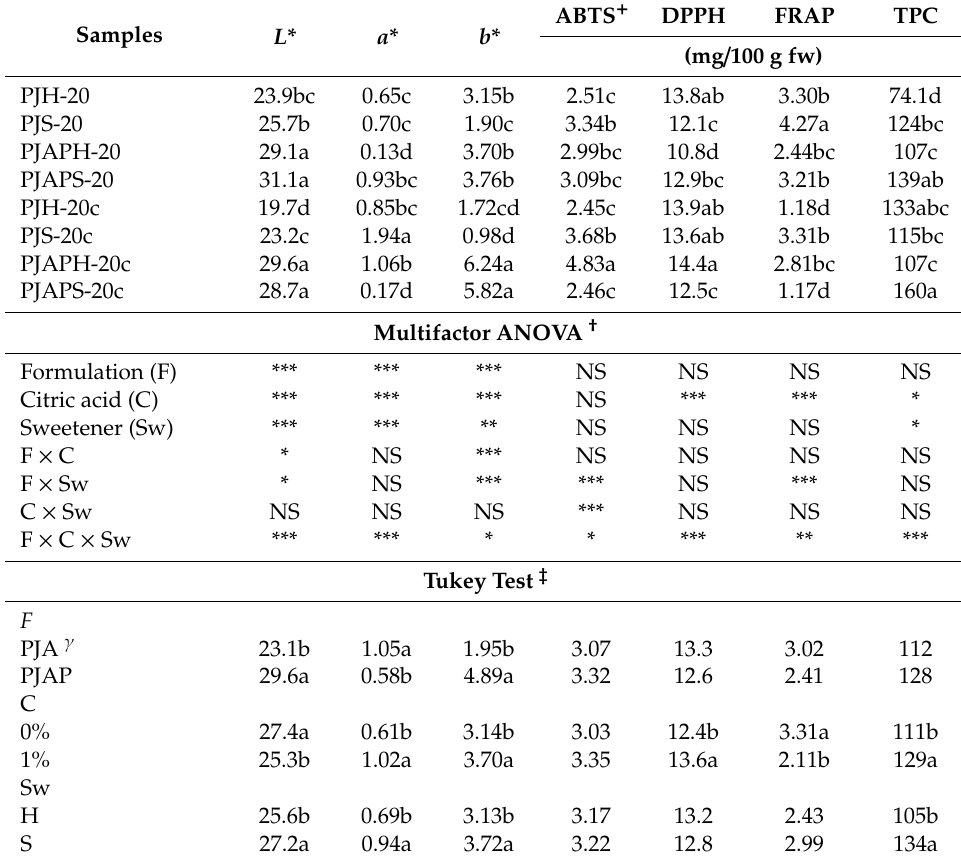
Table 3. E ff ect on color coordinates, antioxidant capacity, and total polyphenol content of pomegranate jellies as a ff ected by formulation, gelatin percentage, and type of